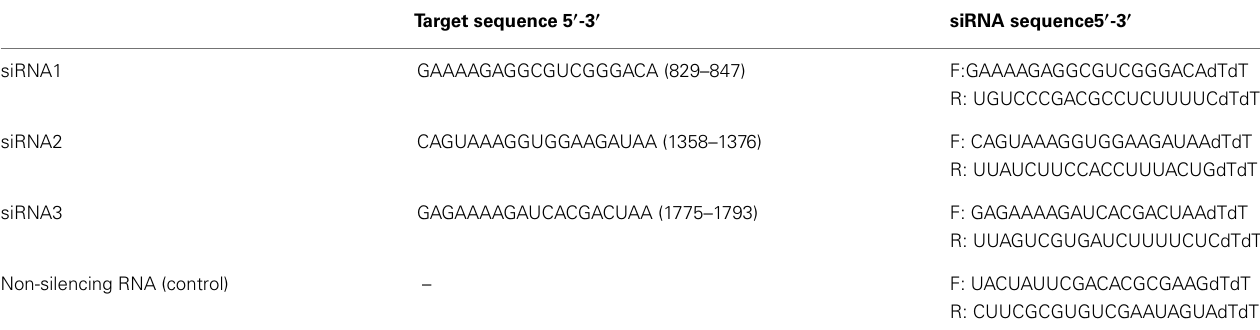
Table 1 | siRNAsequences targeting Bmal1 mRNA.